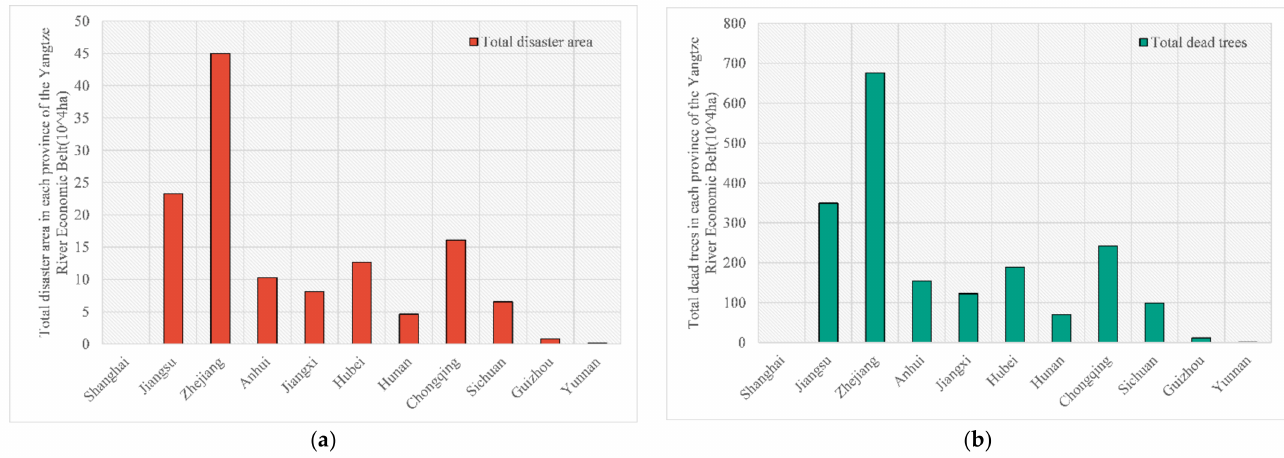
Figure 2. PWD situations in all provinces of the Yangtze River Basin: ( a ) cumulative disaster areas in all provinces; ( b ) the number of dead trees accumulated in each